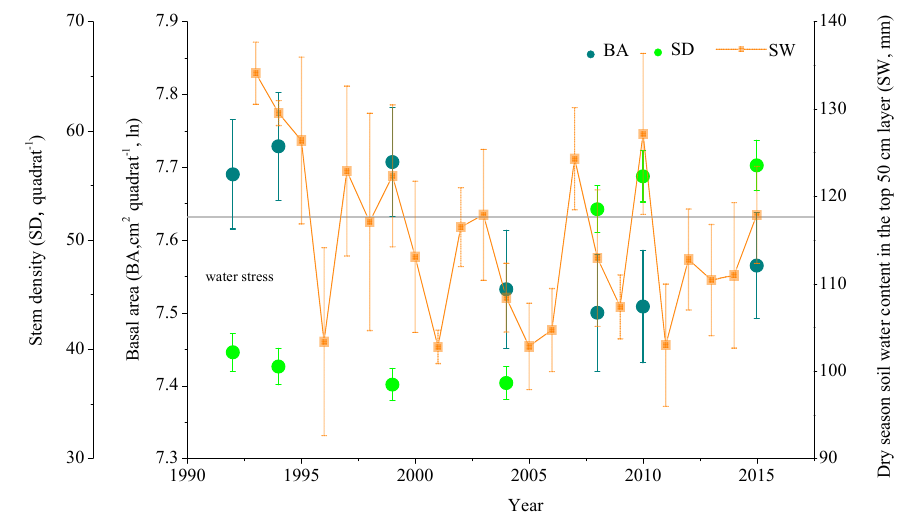
Figure 1. Temporal changes in quadrats’ basal area (BA, cm 2 ; ln, natural logarithm transformed) and stem density (SD), and dry season soil water content (SW, mm) in the top 50 cm layer in DHS plot. Area of a quadrat is 100 m 2 . Error bars are standard errors. Trees suffered soil water stress when SW was below gray line (117.64 mm) in DHS plot according to Zhou et al. 2011 [14].